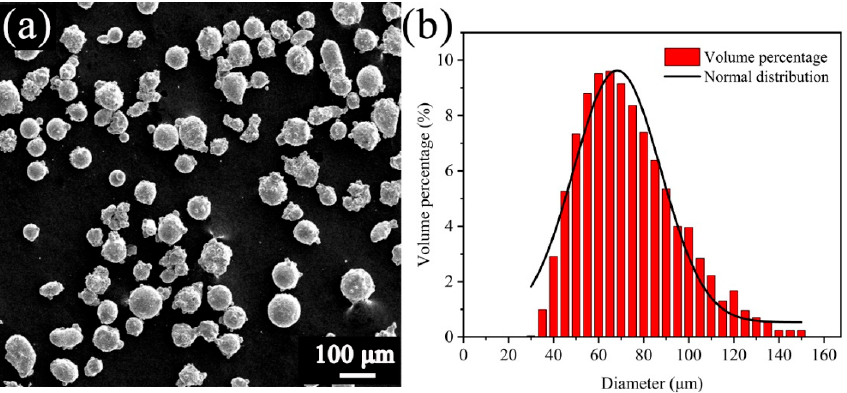
Figure 2. The as-received IN738LC powder: ( a ) the morphology and ( b ) the size distribution. Table 1. The chemical composition of IN738LC powder (wt.%).